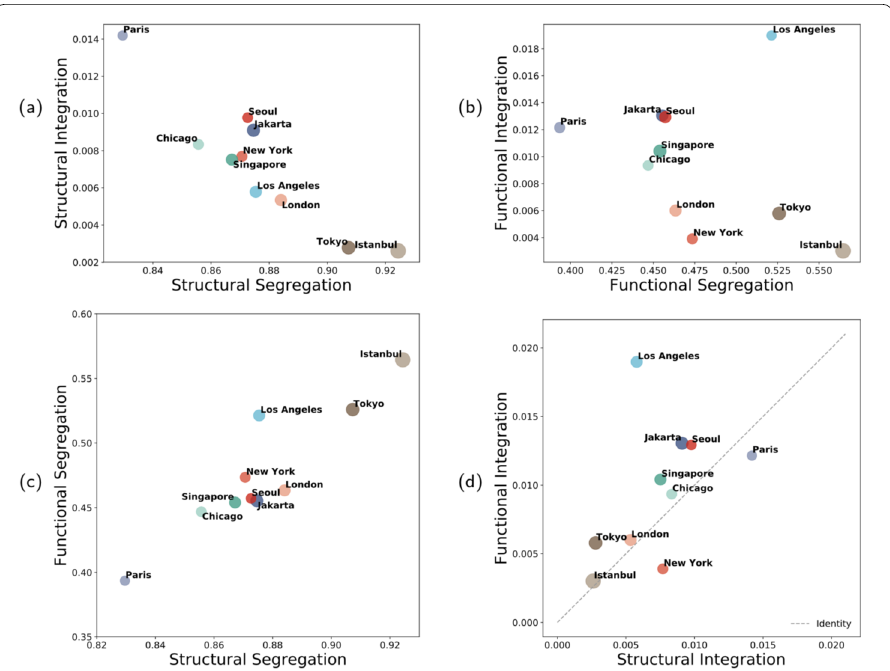
Figure 2 Structural vs Functional organisation of cities measured by means of Segregation and Integration. ( a ) Structural Integration vs Segregation. Analysing the measures of segregation ( Q ∗ ) and Integration (GCE) for the topological un-directed network describing the road structure of cities we observe a very strong anti-correlation (Pearson r = –0.92). ( b ) Functional Integration vs Segregation. The same measures of the weighted network describing the mobility flows display clear deviations from the anti-correlation of integration and segregation, in particular for the city of Los Angeles. ( c ) Structural vs Functional Segregation. The measures of segregation for the two types of networks are strongly correlated (Pearson r = 0.91) but differ in value. ( d ) Structural vs Functional Integration. The measures of integration for the two types of networks deviate from perfect correlation (again due to the deviation of Los Angeles) but are very similar in value. In all panels, the dimensions of the circle is proportional to the size of the area considered